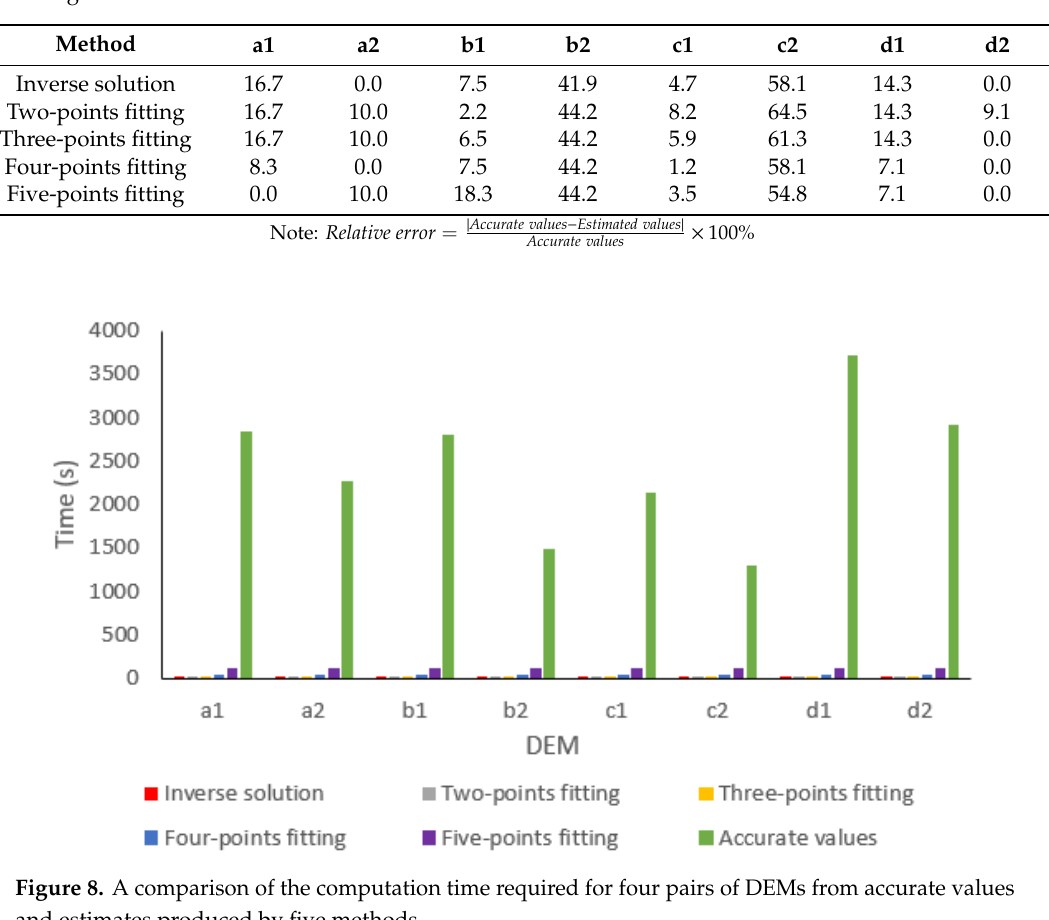
Table 3. The relative errors (%) of the absolute Boltzmann entropy calculated using di ff erent methods for eight DEMs.